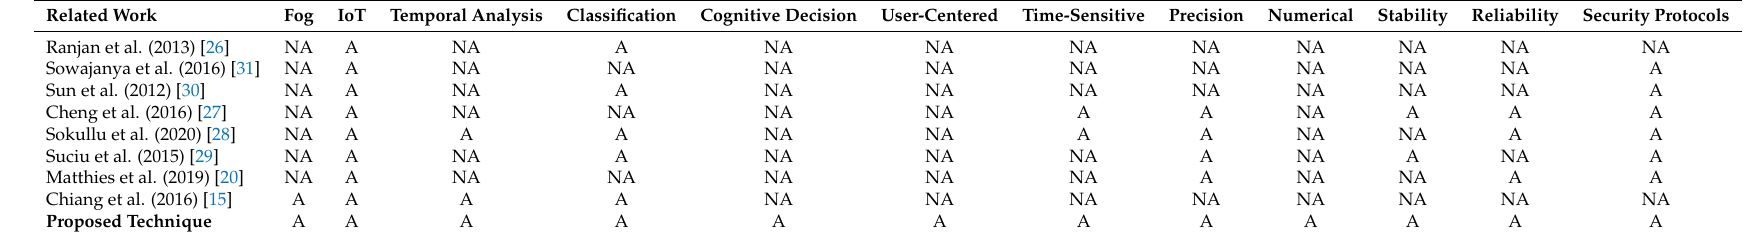
In Table 1, A indicate Available, NA indicate Not